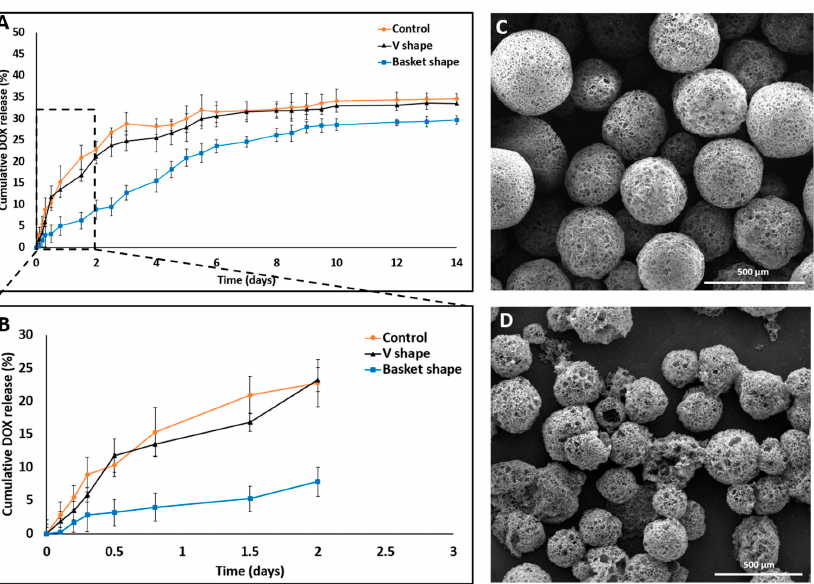
Figure 5. SEM images and DOX release profile studies comparing 3D printed dissolution chips (“V” and “basket” shape) to the dialysis sac method. ( A ) “V” shape chip and dialysis sac methods exhibited similar release behavior both in their release profile and in the total drug released (33%) compared with the “basket” shape chip which exhibited a different release profile and a lower total drug released value (28%). ( B ) Cumulative release in the first 48 h shows a statistically significant difference in the release patterns, with an artificial lower “burst effect” using the “basket” chip. All three experiments achieved a plateau by the end on day 14. ( C ) DOX-PMS1 at day 0. ( D ) DOX-PMS1 at day 14 (empty particles were used as control. n = 3; mean ±